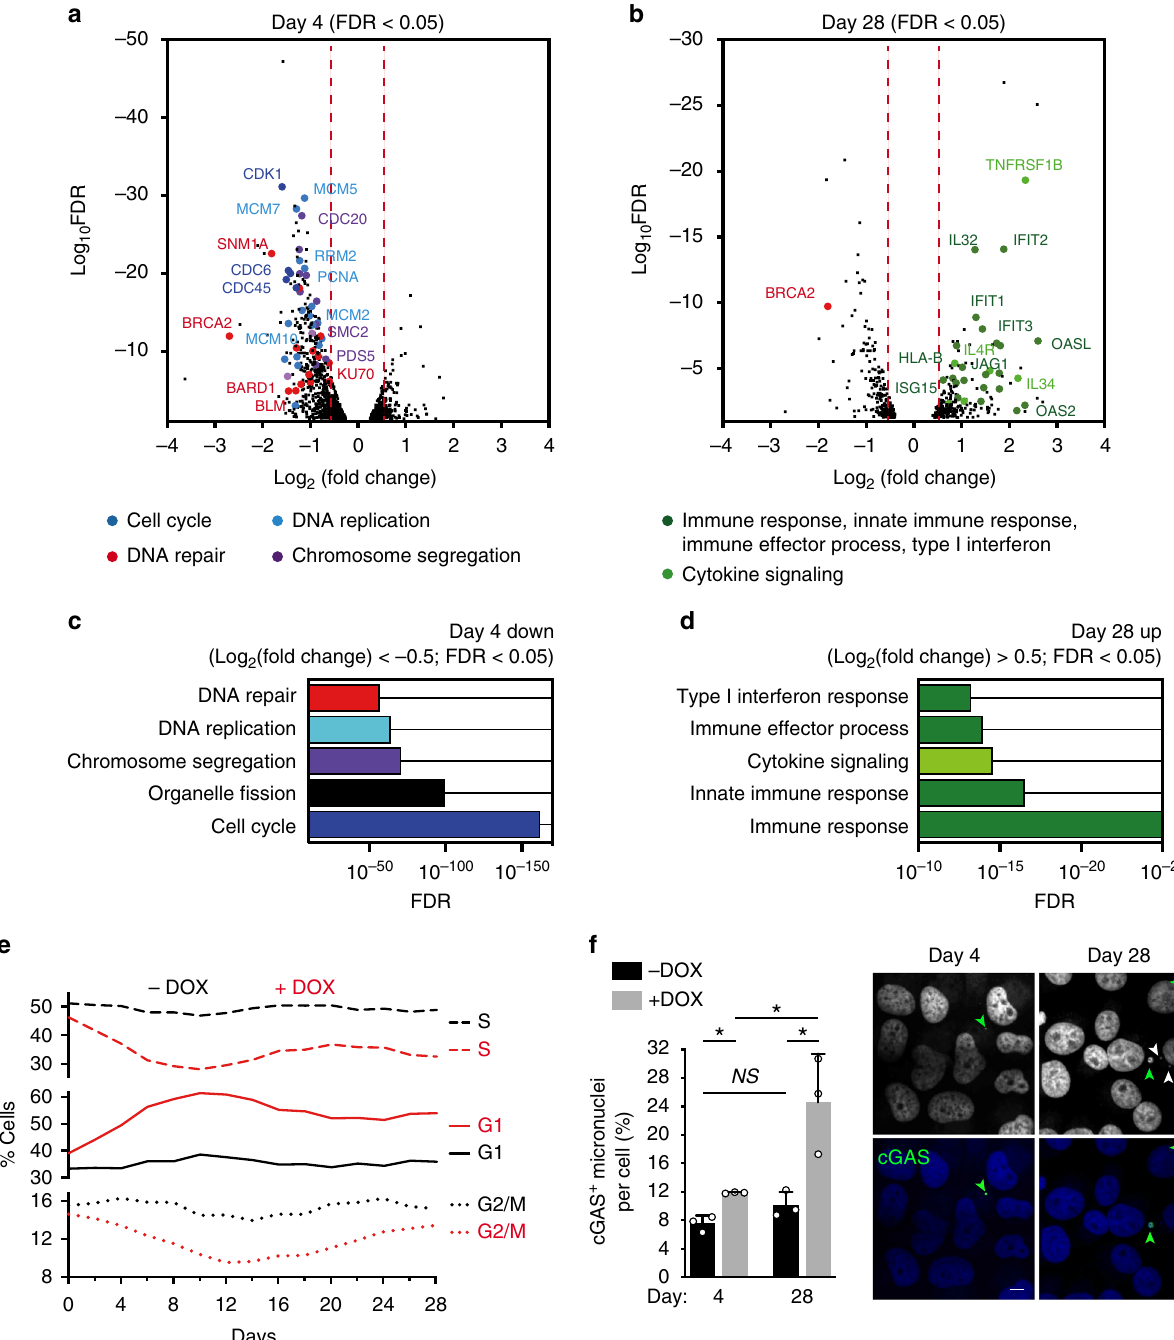
Fig. 2 Pathway deregulation in BRCA2-de fi cient H1299 cells during short-term (4 days) or long-term (28 days) BRCA2 inactivation. a , b Volcano plot of genes differentially expressed (FDR < 0.05) in BRCA2-de fi cient versus BRCA2-pro fi cient H1299 cells, after DOX treatment for 4 ( a ) or 28 ( b ) days. A subset of the genes signi fi cantly downregulated (Log 2 (Fold Change)< − 0.5) after 4 days or signi fi cantly upregulated (Log 2 (Fold Change) > 0.5) after 28 days of DOX treatment is shown. c , d Gene set enrichment analysis based on functional annotation (Gene Ontology — Biological Process database) of genes downregulated after 4 days ( c ) or upregulated after 28 days ( d ) of DOX treatment. e Cells were pulse-labeled with EdU for 30 min. Frequency of cells in G1, S, and G2/M stages of the cell cycle were determined using FACS analyses of EdU-labeled cells. f Cells were fi xed and stained with antibody against cGAS after 4 days or after 28 days of DOX treatment. DNA was counterstained with DAPI. Shown are representative images of cells treated with DOX. cGAS-positive micronuclei were quanti fi ed and related to number of cells. Error bars represent SD of n = 3 independent experiments. NS , p > 0.05; *, p < 0.05 (unpaired two-tailed t test). Green arrows indicate cGAS-positive micronuclei and white arrows indicate cGAS-negative micronuclei. Scale